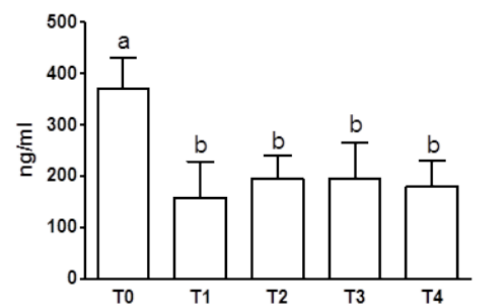
Figure 4. Blood 5-HT levels (mean values ± SD) in aggressive dogs ( n = 8) at T0 (before treatment)